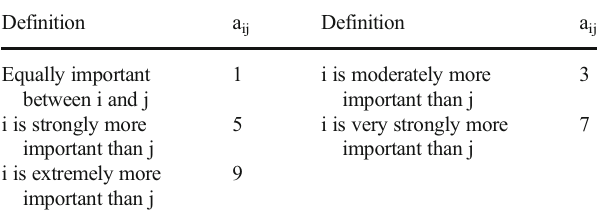
Scales of pair-wise comparison in